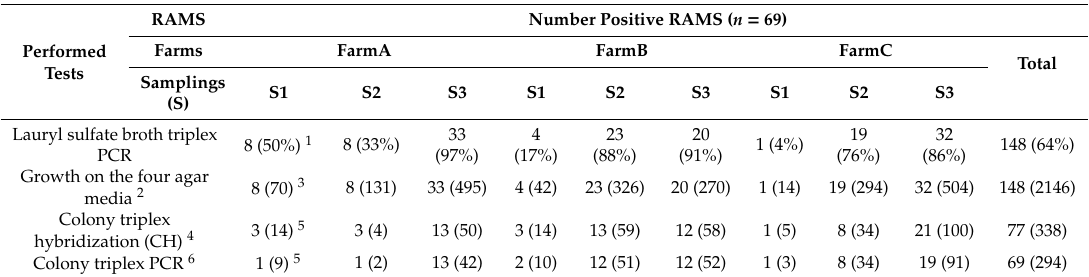
Table 1. Results of the di ff erent tests performed on the 233 recto-anal mucosal swabs (RAMS) and isolated colonies from < 6-month-old calves in three farms during three sampling